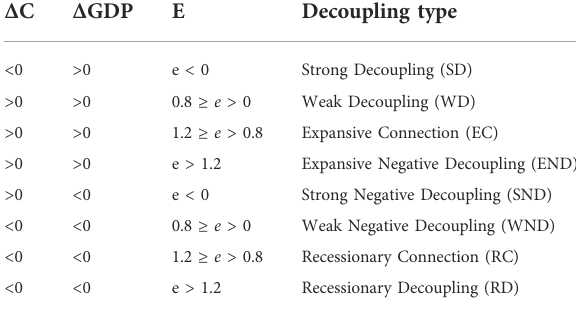
FIGURE 1 Location map of provinces in the YRB.